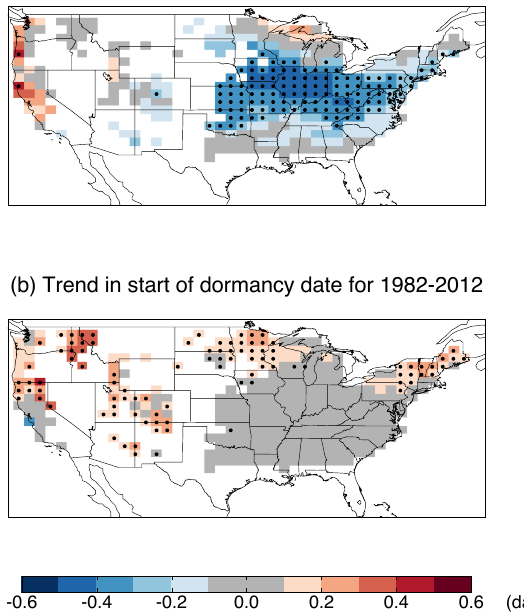
Figure 5. Trend in the simulated (a) budburst and (b) dormancy dates for deciduous forests in the USA during 1982–2012. Simula- tions are performed with the spring model S9 and autumn model A4. The results are shown only for the grid squares where the fraction of deciduous forest is larger than 3%. Significant trends ( p <0.05) are denoted with